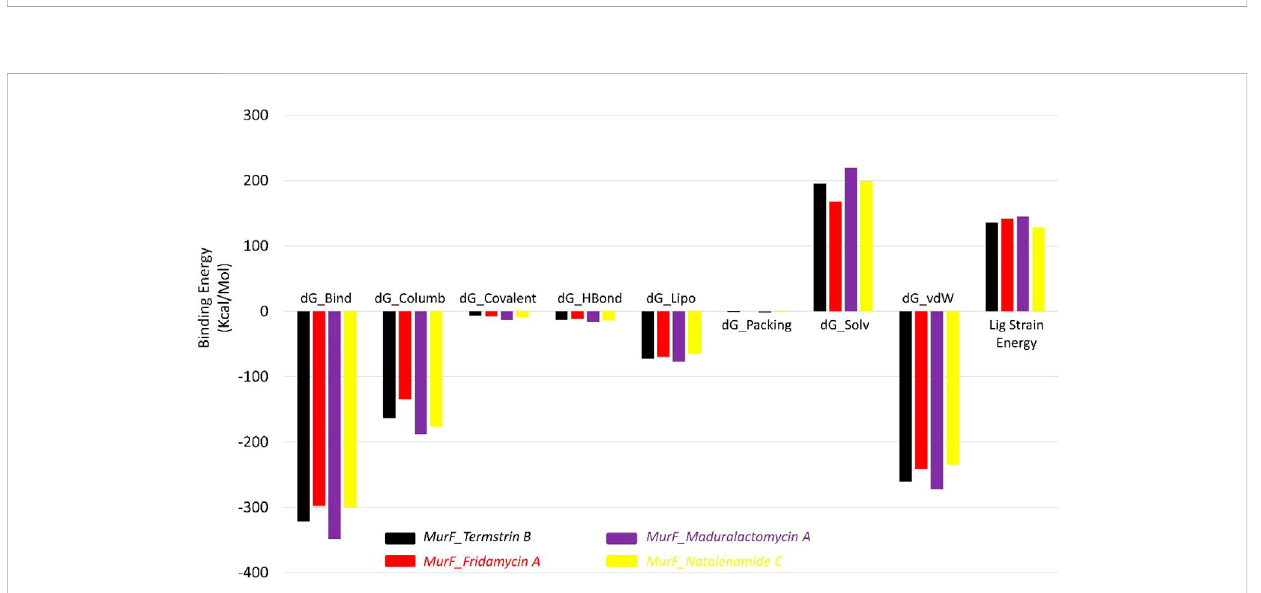
FIGURE 9 The Molecular mechanics, Generalized Born, and surface area solvation energies for Termstrin B (black), Fridamycin A (red), and Maduralactomycin A (indigo) and Natalenamide C (yellow) in complex with MurF (4ZIY) of A. baumannii .